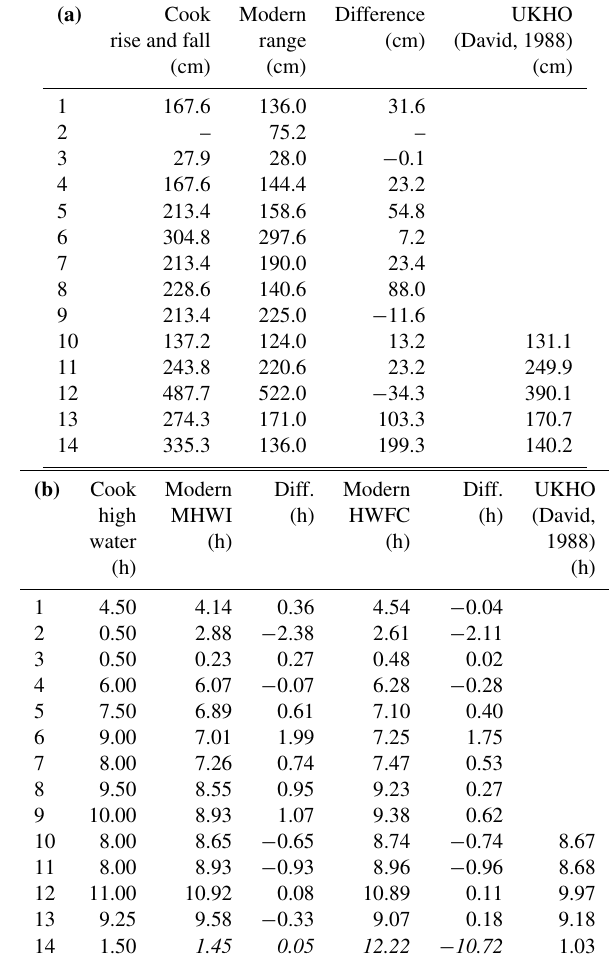
Table 3. (a) Range of the tide at new and full moon (from Cook) or at springs (from modern constants), and their difference. Modern range reported for Australian stations in David (1988). Unit: cm. (b) The time of high tide at new and full moon (from Cook), MHWI (from modern constants) and their difference from Cook, HWFC (from modern constants) and their difference from Cook. HWFC reported for Australian stations in David (1988). Unit: hours. Mod- ern MHWI and HWFC for Possession Island (station 14) are shown in italics as they are not meaningful quantities at this location (see Sect.